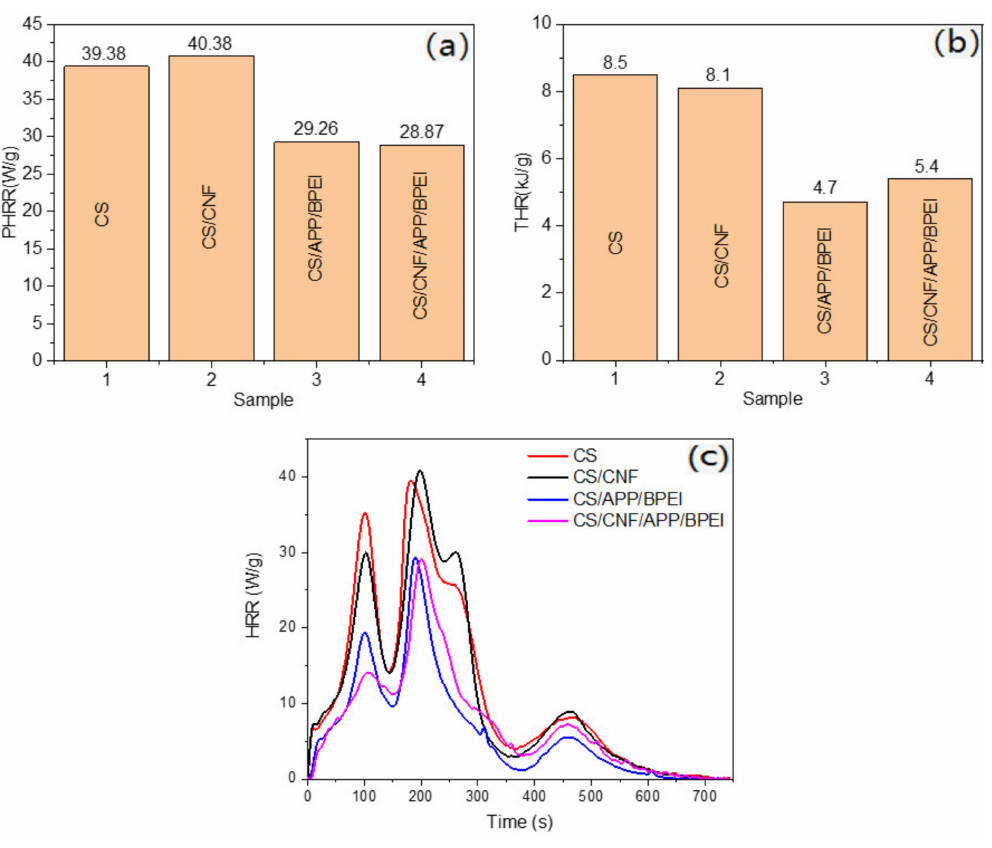
Figure 7. The ( a ) PHHR capacity comparison, ( b ) TRR comparison, ( c ) HRR curves of the different CS-based composite films.